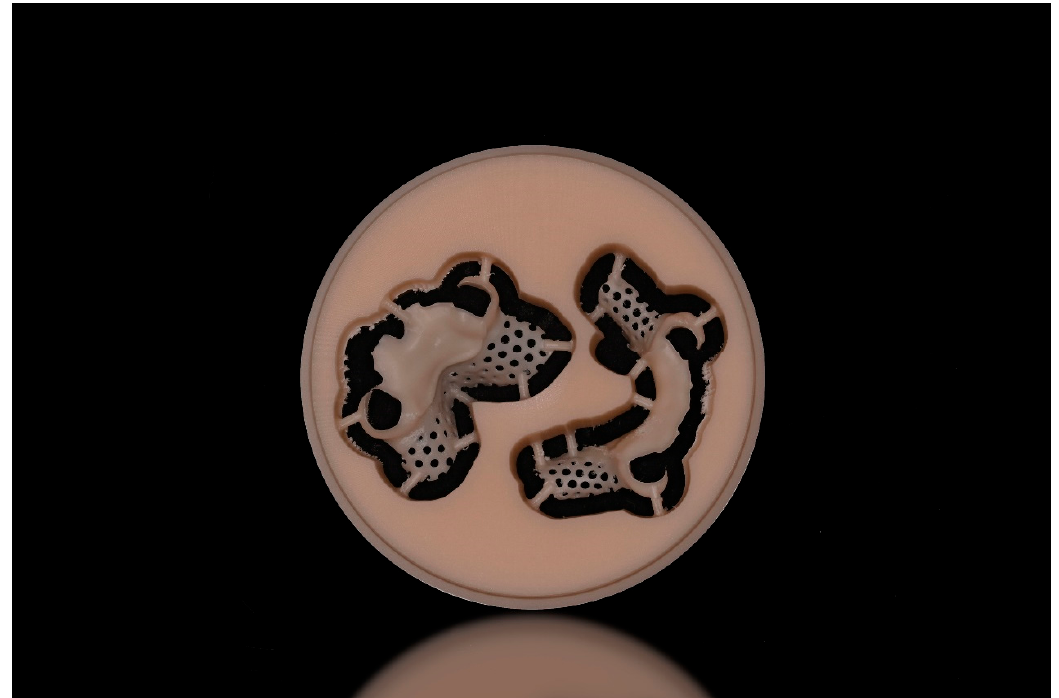
Figure 2. Milled polymer-based frameworks with supports in place. After removal of the supports, frameworks require finishing and polishing prior to beginning tooth setting.